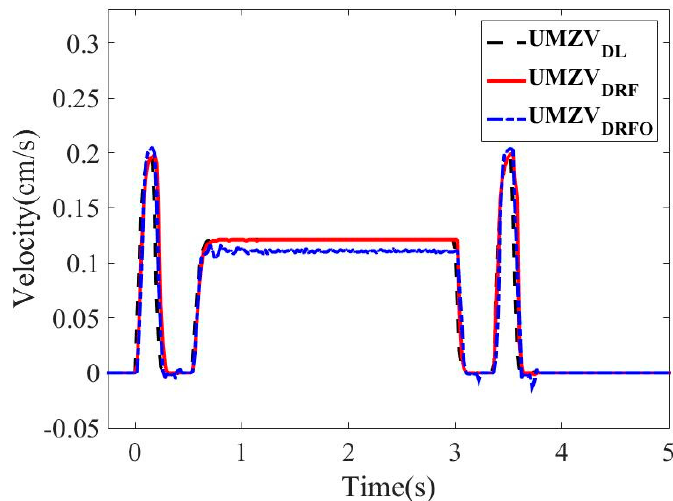
Figure 15. Experimental velocity commands.